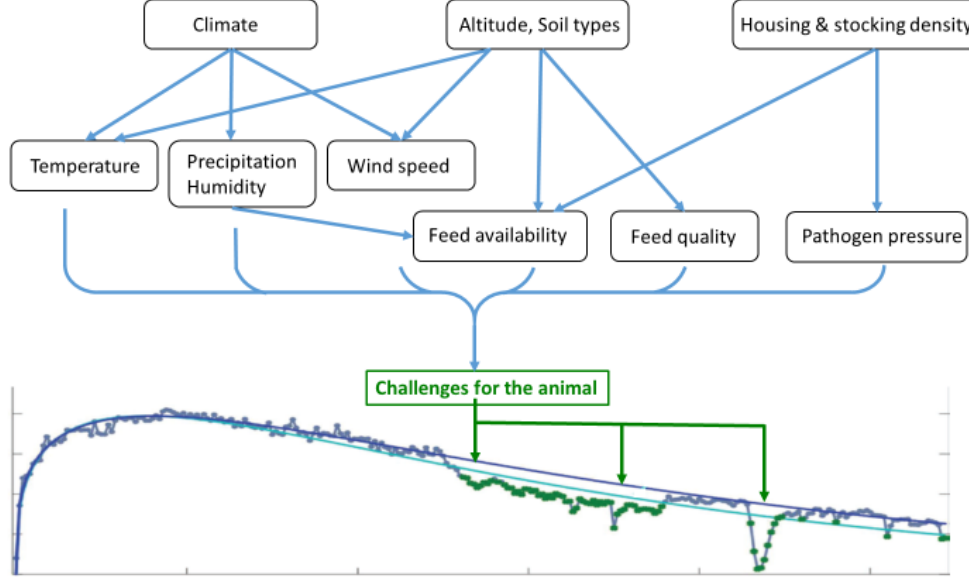
Figure 2: A non-exhaustive representation of environmental factors causing challenges for the animal. In this representation, challenges are visualized as perturbations (green) in the milk yield curve of a given